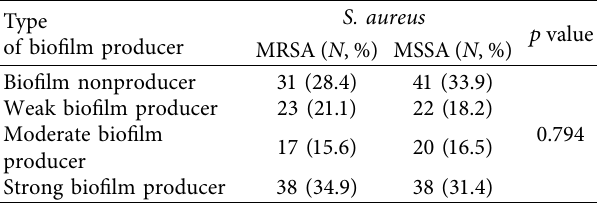
Table 3: Distribution of bioflm forming MSSA and